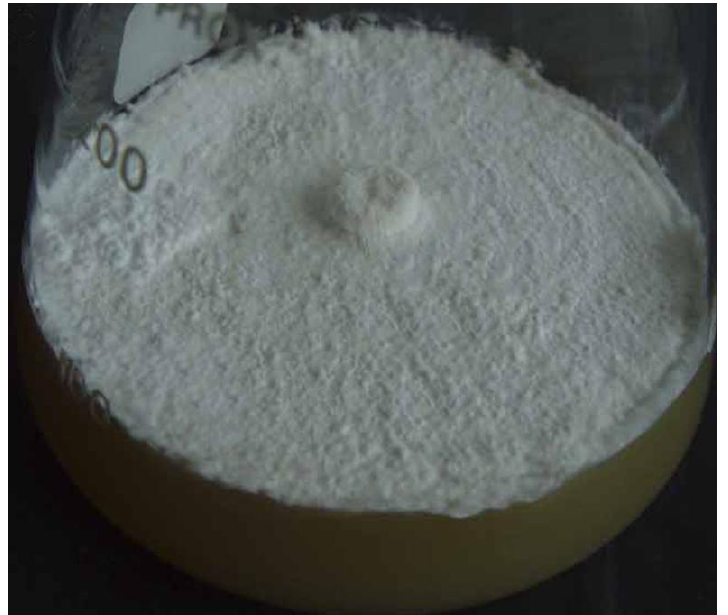
Figure 2. The effect of diphenyleneiodonium (DPI) (1 mmol L −1 ) on P. umbellatus sclerotial formation by the temperature shift treatment. No sclerotia were formed after 120 days of cultivation at 8 °C. Representative images were obtained from three independent